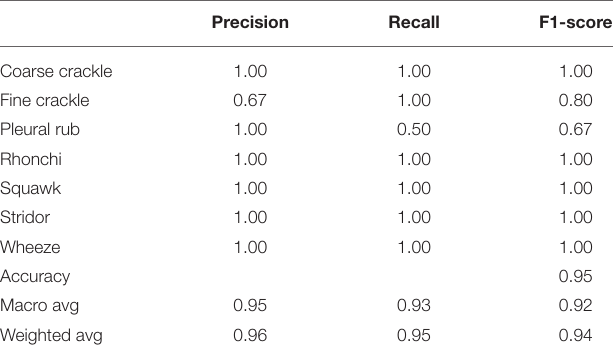
TABLE 2 | Comparative results obtained (Precision and Recall) for VGG-B1.